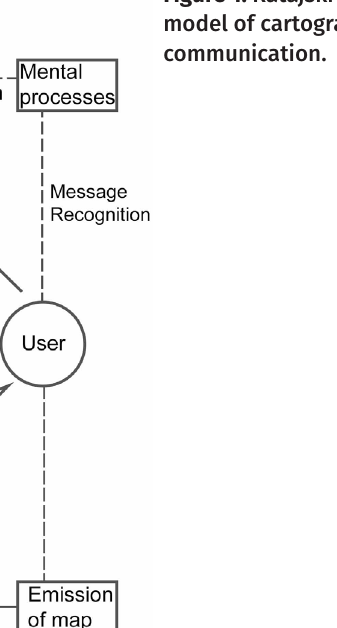
Figure 1. Ratajski model of cartographic